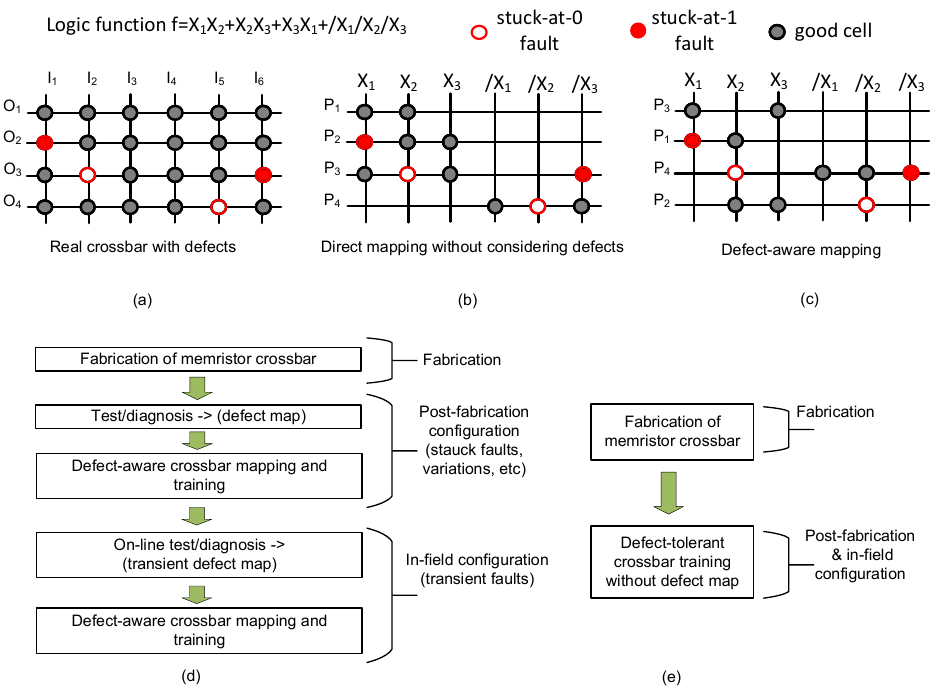
Figure 2. ( a ) The real crossbar with defects; ( b ) the direct mapping of the logic function without considering the defect map; ( c ) the defect-aware mapping of the logic function with considering the defect type and location; ( d ) the flowchart of crossbar training using the conventional defect-aware mapping [21]; and ( e ) the proposed flowchart of the defect-tolerant crossbar training without using the defect map.